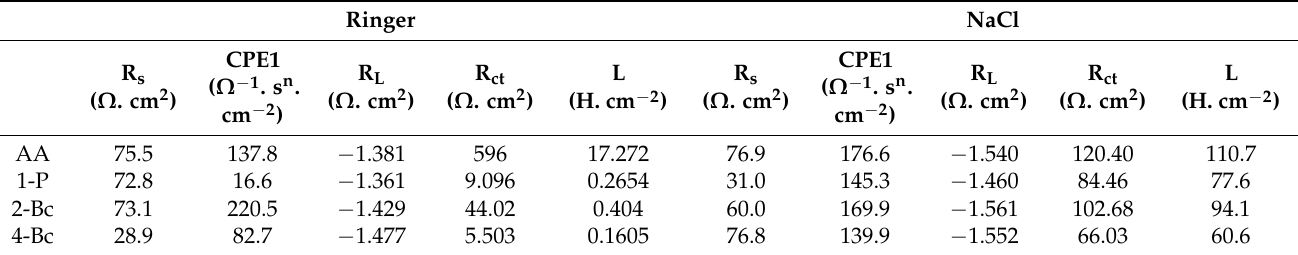
Table 3. Electrical parameters obtained from fitting the electrochemical impedance spectroscopy